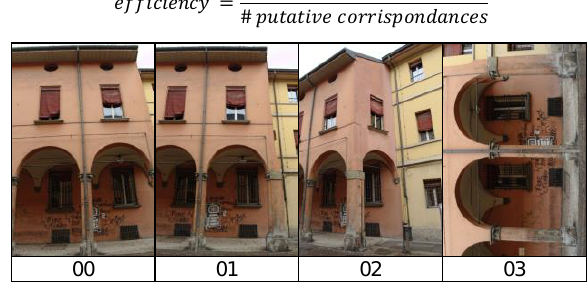
Figure 2: Images used to test pairwise matching efficiency.